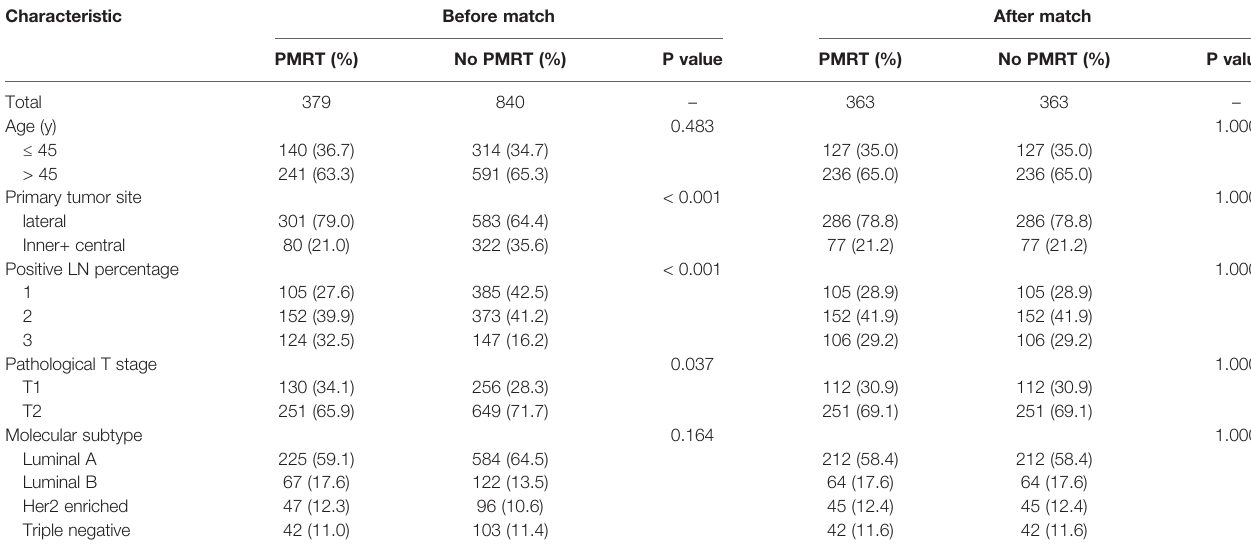
TABLE 5 | Clinical characteristics of moderate-risk patients with pT1-2N1M0 breast cancer before and after PSM 1:1 strati fi cation by treatment. Characteristic Before match After